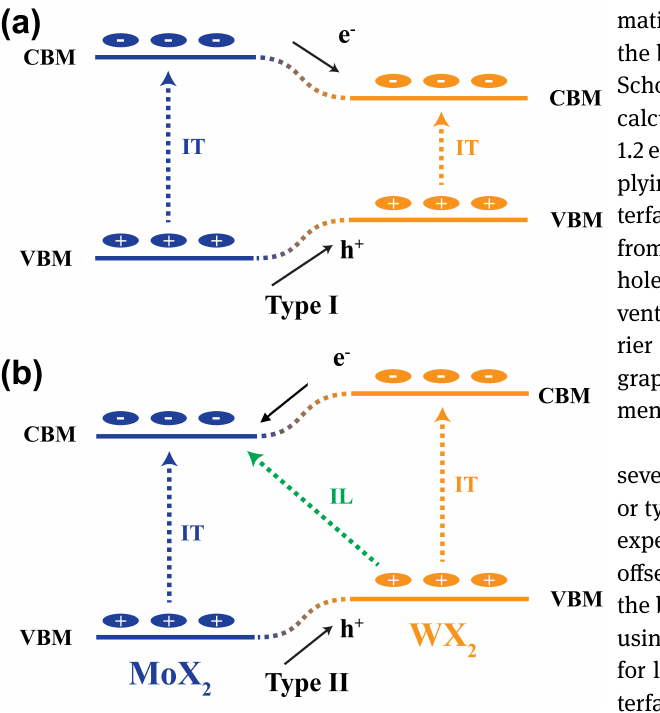
Figure 3: Type-I (a) and type-II (b) band alignments at hetero-bilayer interfaces. Shown are the VBM and CBM energy levels of each monolayer composing the interface, together with the direction of the electron (e) and hole (h) transfer at the interface. IT and IL indicate, respectively, intralayer and interlayer optical